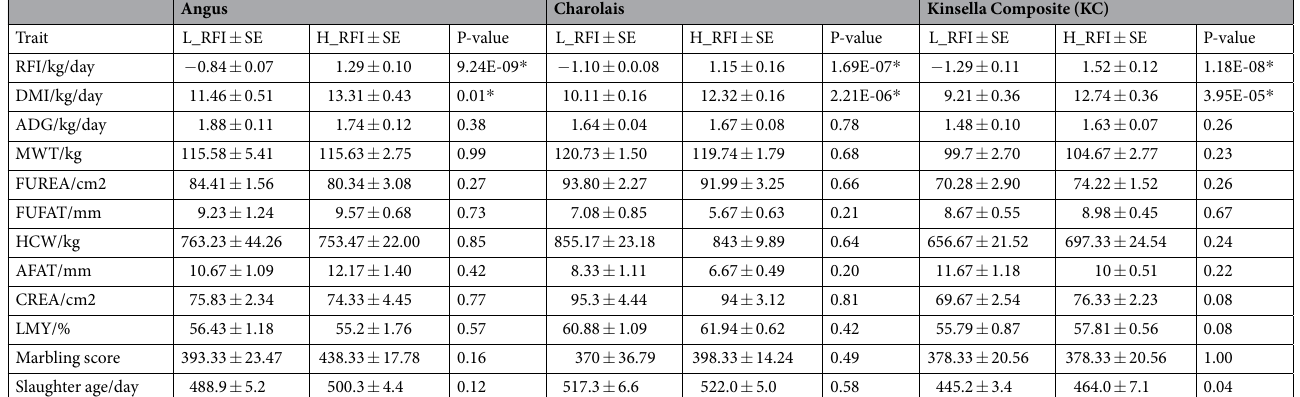
Table 1. Differences of RFI and other performance traits between groups of high (n = 6) and low RFI steers (n = 6) of the three breeds, “ * ” indicates significant difference (P-value ≤ 0.01). RFI = residual feed